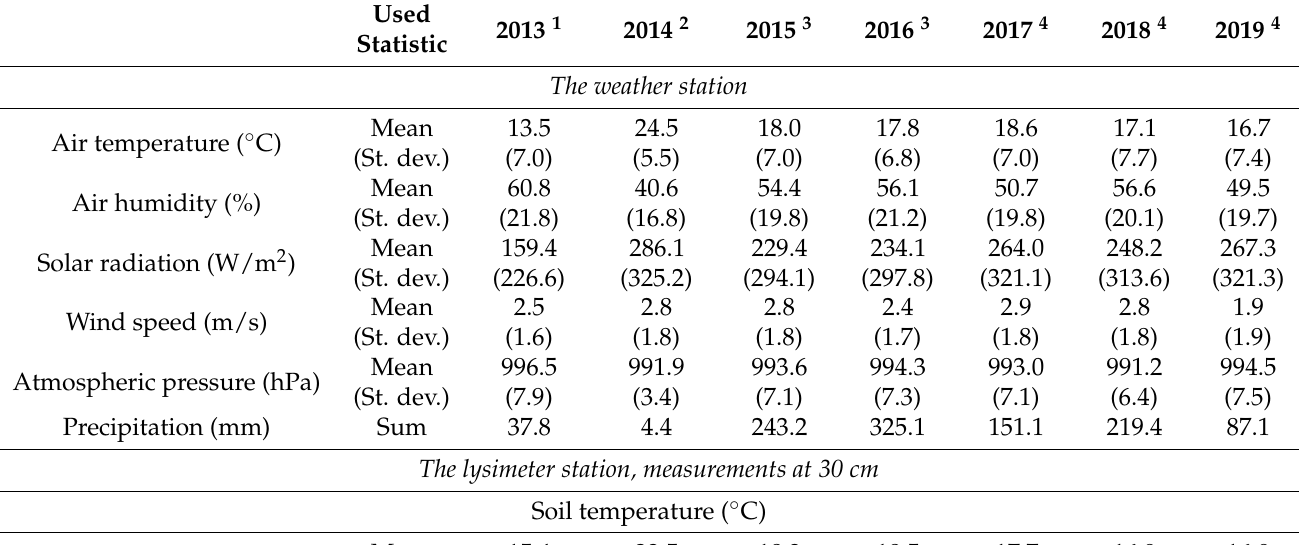
Table A1. The climatic conditions and descriptive statistics of soil temperature and soil moisture at the 30 cm depth during the vegetation period (May–September) for 2013–2019, Poluyamki, Altai Krai,